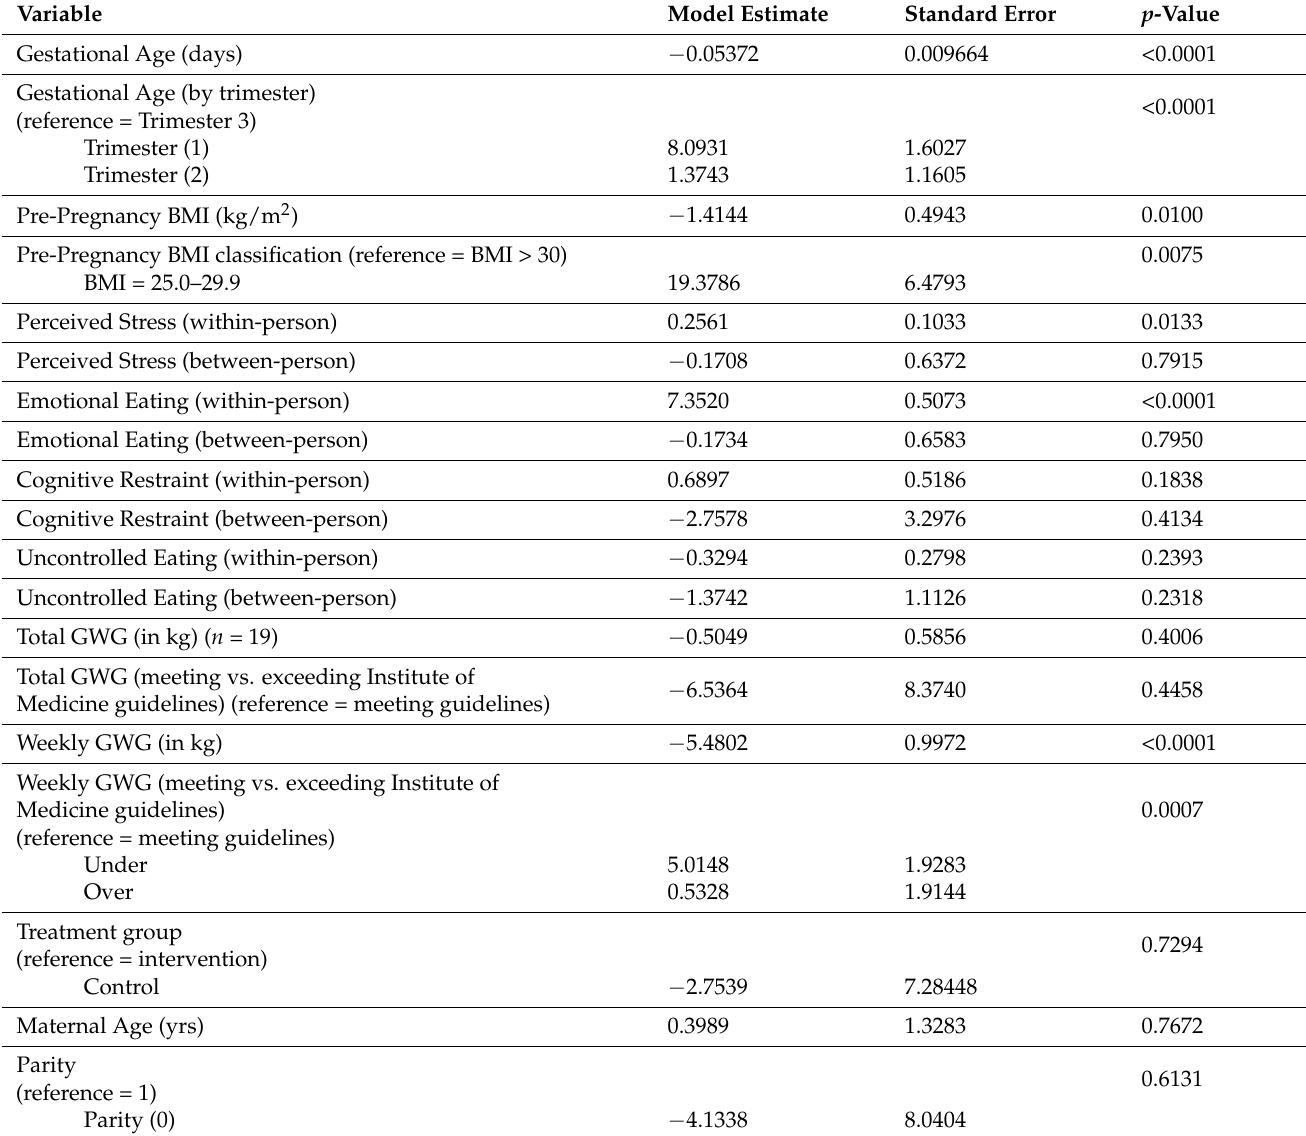
Table 3. Predictors of maternal underreporting of energy intake during pregnancy in women with overweight and obesity a ( n =